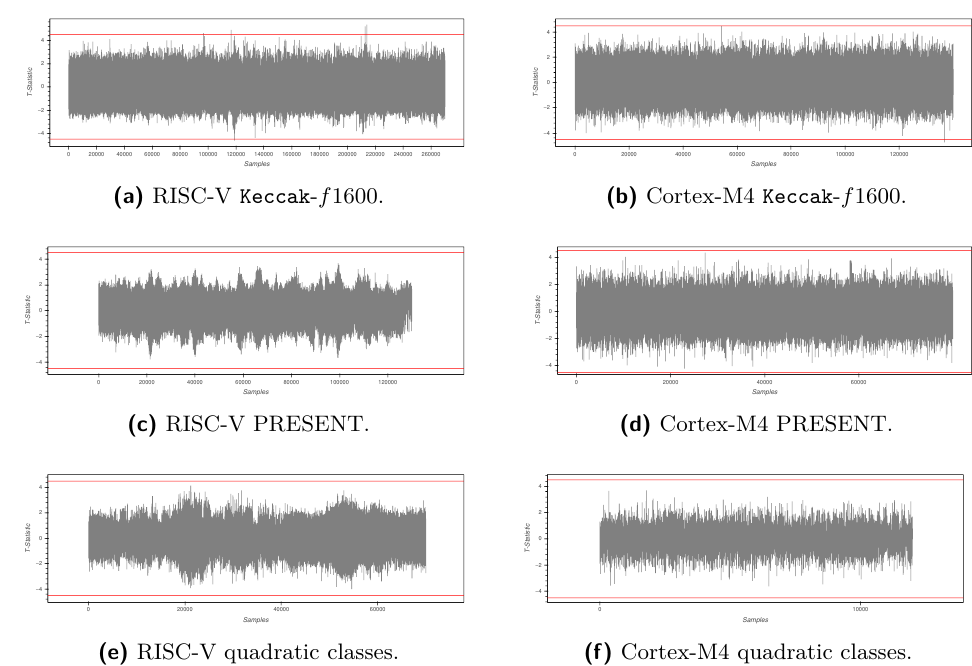
Figure 8: First-order non-specific , fixed vs. random t-test results on RISC-V and Cortex-M4 cores with 1M traces. The ± 4 . 5 threshold is marked by red